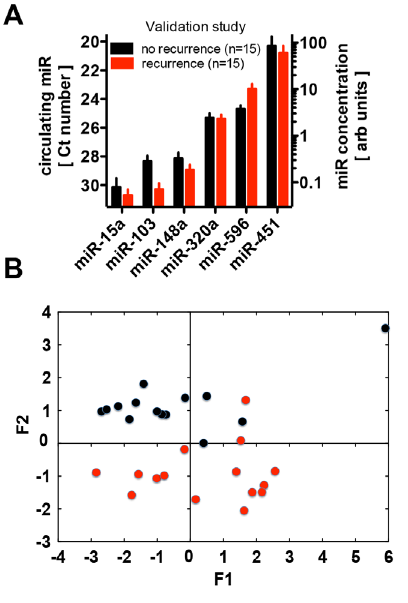
Figure 4. miR expression levels in serum samples from patients with or without recurrence of early stage colon cancer. Validation study for six miRs identified in the Pilot study. Patient characteristics are provided in Table 1. Six miRs were derived from the pilot study. A , Expression levels based on the cycle threshold (Ct) values of the qRT-PCR (left axis) and the miR concentration calculated (right axis). B , Principal Component Analysis of the data with the two groups shown in black and red symbols